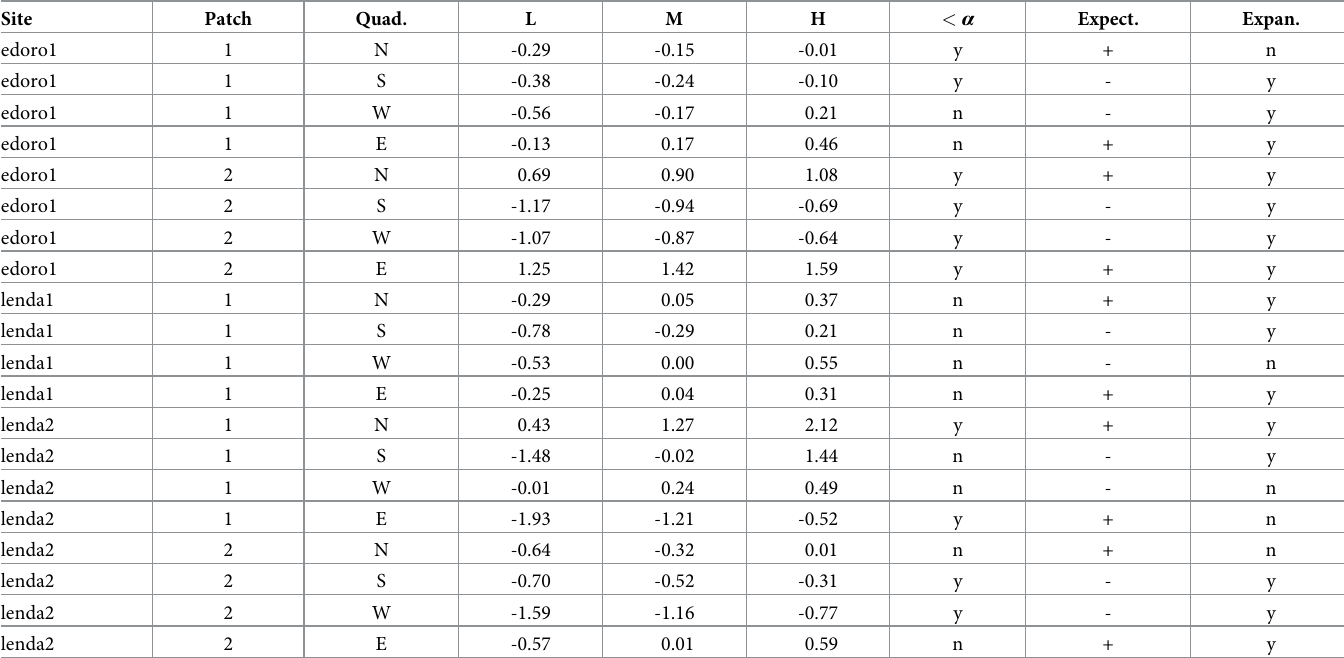
Table 2. Bootstrapped results ( n = 10, 000) of Gilbertiodendron -dominated forest patch boundary movement modeling. Site